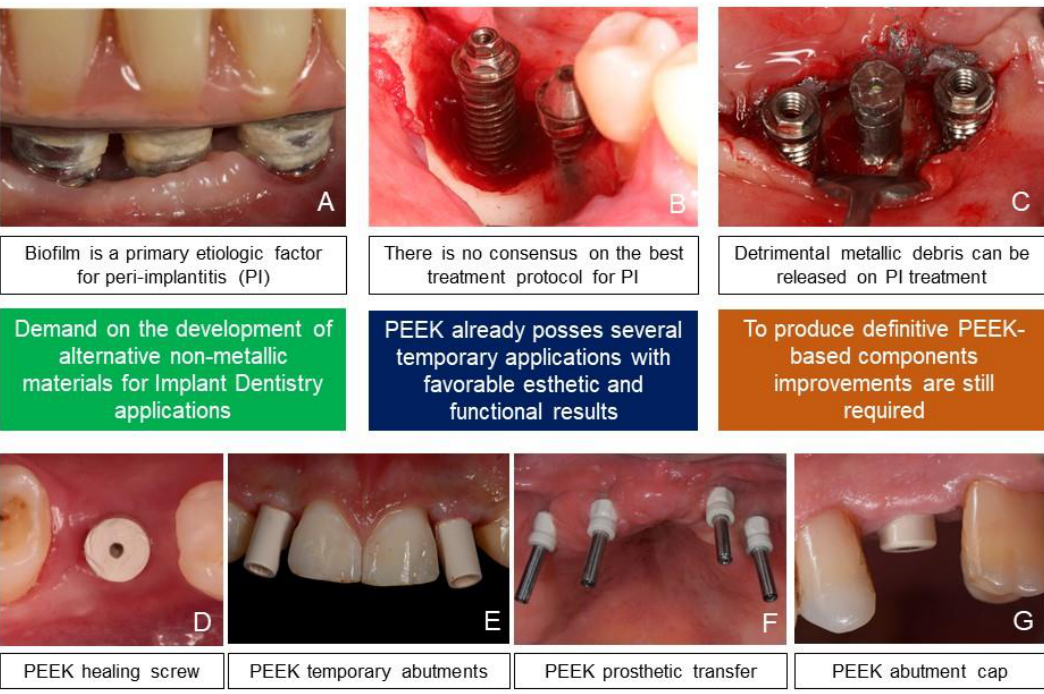
Figure 1. ( A ) Biofilm formation on titanium implants, underneath an implant-supported total prosthesis; ( B ) bone defects around dental implants at posterior lower jaw, a sequel of peri-implantitis; ( C ) metallic debris being released to peri-implant tissues during peri-implantitis treatment (implantoplasty); ( D ) PEEK healing screw (FGM, Brazil); ( E ) PEEK temporary abutments (Straumann, Switzerland) that support esthetic restorations; ( F ) PEEK prosthetic transfers (FGM, Brazil); ( G ) PEEK abutment cap (Straumann, Switzerland).